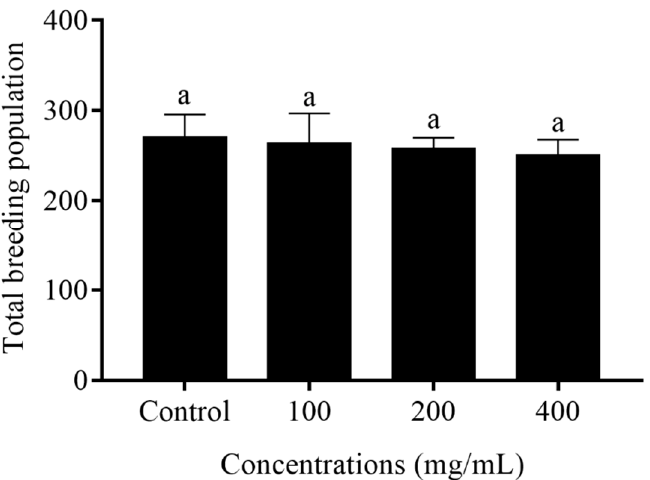
Figure 3. Effect of orange extracts on the total breeding population in N2 wild-type C. elegans . Nematodes were incubated in the presence of orange extracts at different concentrations of 0, 100, 200, or 400 mg/mL. The number of offspring of each worm were counted until the parental nematode stopped producing progeny (about day 6). All data were determined in triplicate (mean ± SD, n = 3). The bars with different letters indicate statistical significance.